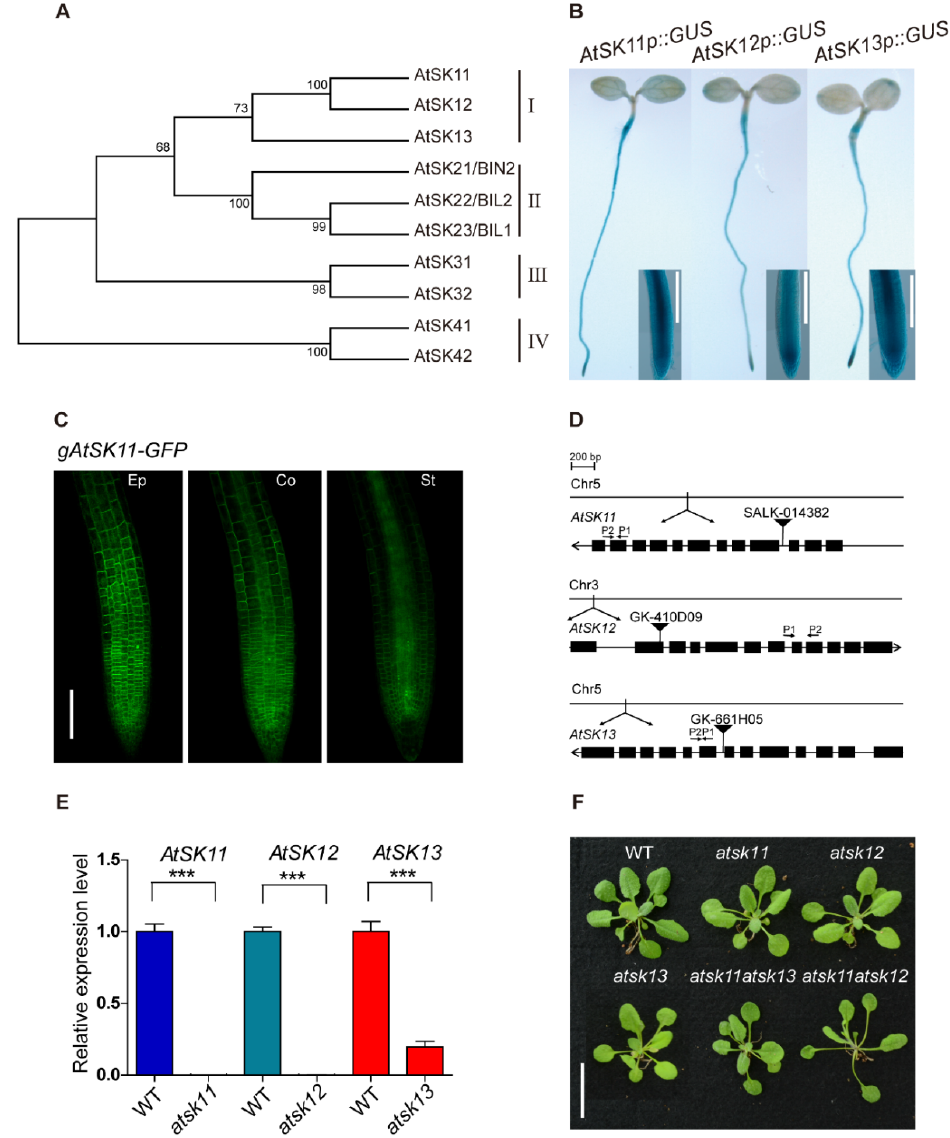
Figure 1. GLYCOGEN SYNTHASE KINASE 3 (GSK3) members AtSK11, AtSK12, and AtSK13 are highly expressed in the root tip. ( A ) Phylogenetic analysis of the Arabidopsis GSK3-like kinase gene family. Amino acid sequences were downloaded from the TAIR database, aligned with Clustal W. The evolutionary history was inferred using the maximum parsimony method. The percentages of replicate trees in which the associated taxa clustered together in the bootstrap test (1000 replicates) are shown. The evolutionary tree was constructed with MEGA7. ( B ) GUS staining of 5-day-old AtSK11p::GUS , AtSK12p::GUS , and AtSK13p::GUS seedlings. The rectangles show magnified views of the root tip images. Bar = 0.2 mm. ( C ) Subcellular localization of AtSK11-GFP in root tip cells. Images show epidermal (Ep), cortex (Co), and stele (St) cells in the root tips of 5-day-old gAtSK11-GFP transgenic seedlings. Bar = 0.1 mm. ( D ) Diagram of the T-DNA insertions in atsk11 , atsk12 , and atsk13 . The qRT-PCR primer locations are labeled with arrows in the figures; P1 indicate forward primers and P2 indicate reverse primers. ( E ) Expression levels of AtSK11 , AtSK12 , and AtSK13 , as detected by qRT-PCR, data were replicated in three times. Error bars indicate SD. Student’s t -test was used to determine the significance of difference between wild-type (WT) and mutant. Significant levels: *** p < 0.001. ( F ) Phenotypes of 3-week-old WT, atsk11 , atsk12 , atsk13 , atsk11atsk12 , and atsk11atsk13 rosettes. Bar = 2 cm.